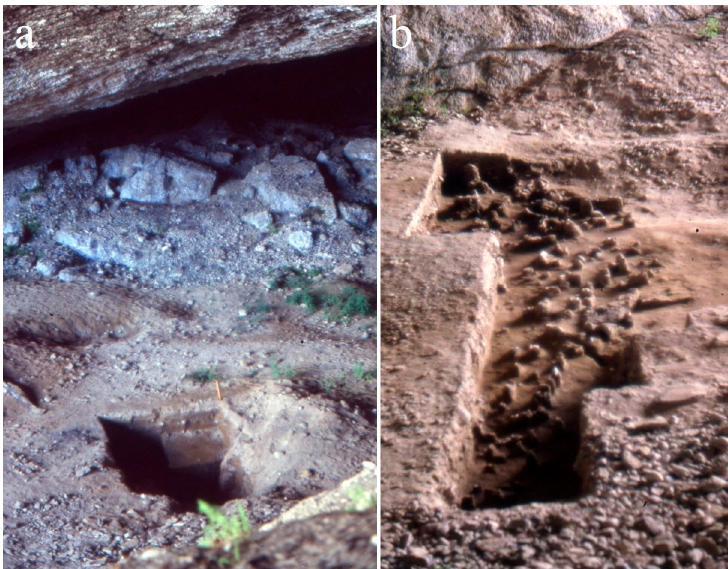
Figure 5. Images of the excavation made at CM during the different field-works. ( a ) Made during the first expedition. Several looters’ pits can be seen around it, one of which was used to start the excavation, ( b ) Paleo-American level exposed during the third expedition.